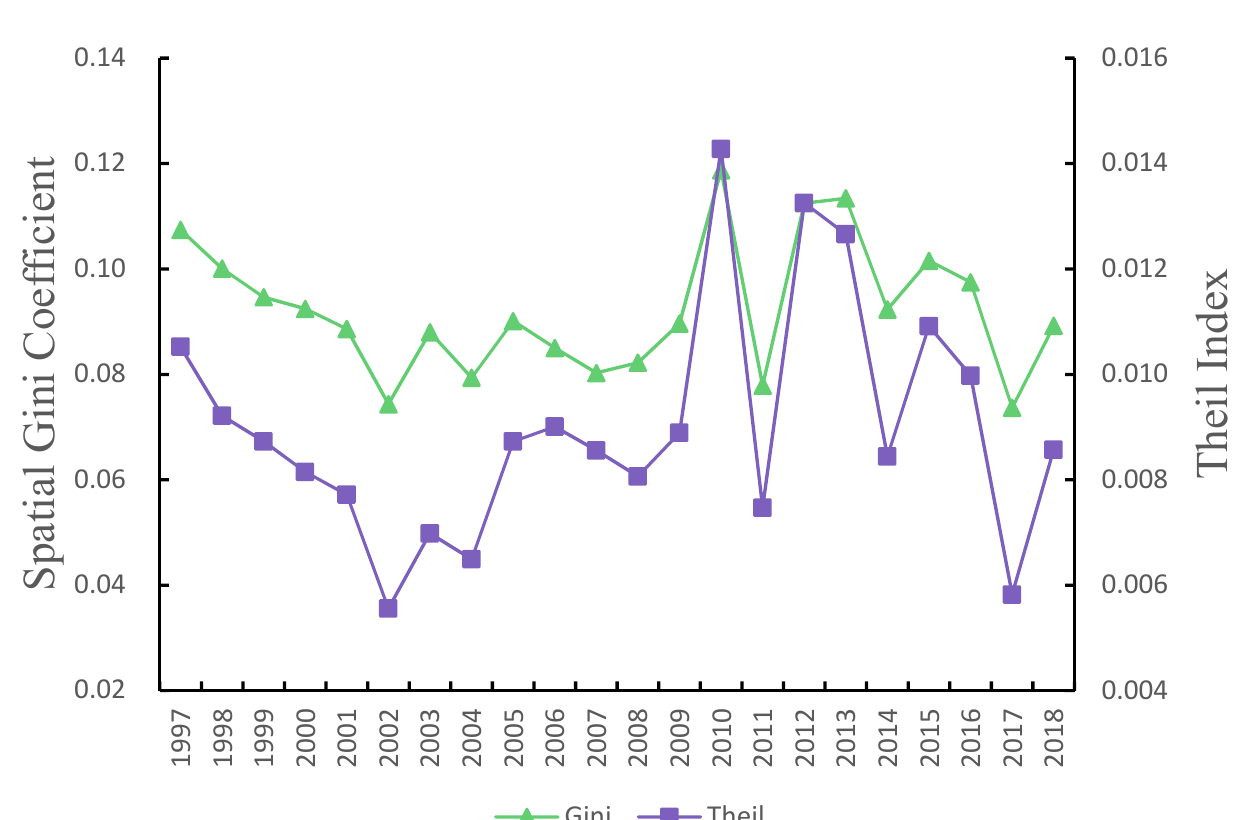
Figure 3. Spatial Gini coefficient and Theil index of ecological well-being performance in China.